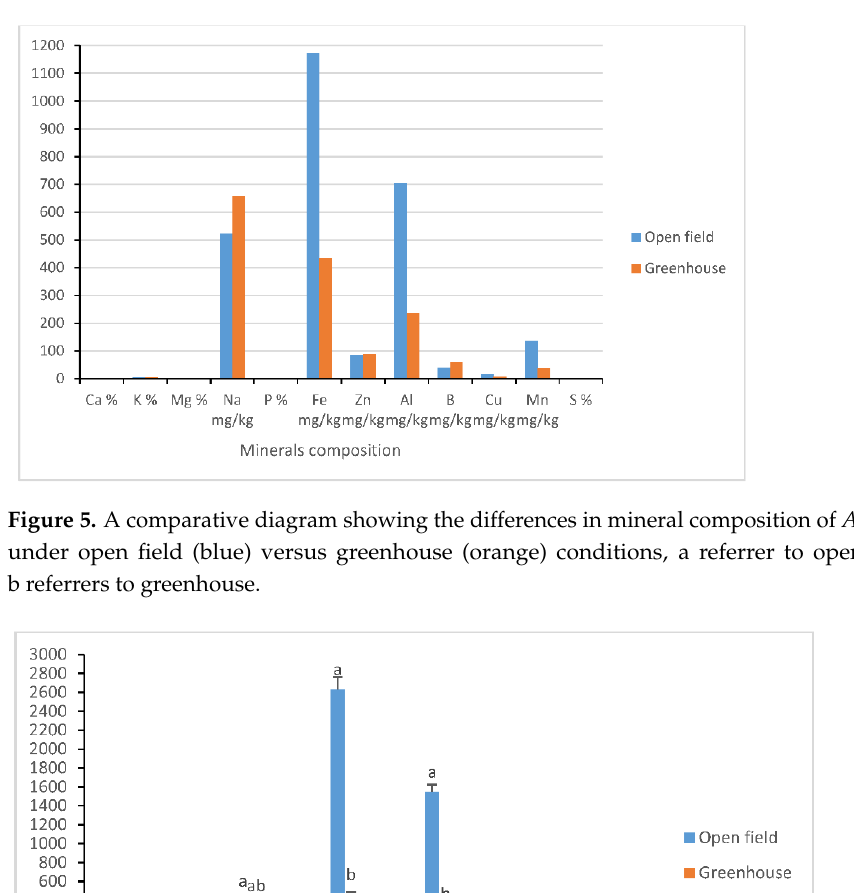
Table 6. Comparison of mineral composition of A. Cruentus L. in open field vs. greenhouse on a dry weight basis.